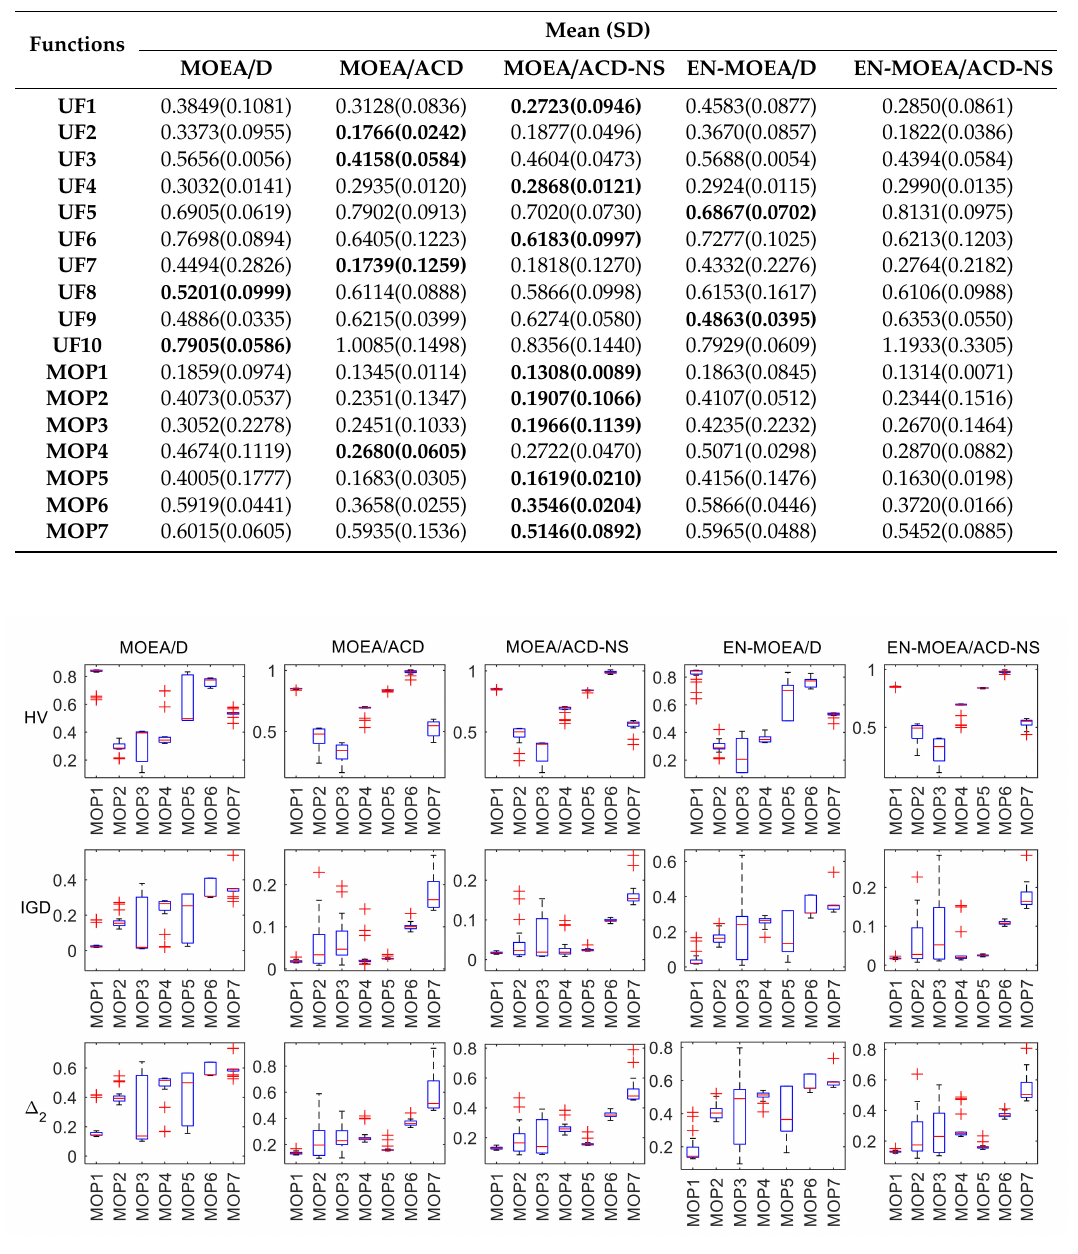
Figure 1. Box plots of the distribution of HV, IGD, and ∆ 2 values using five test algorithms in the